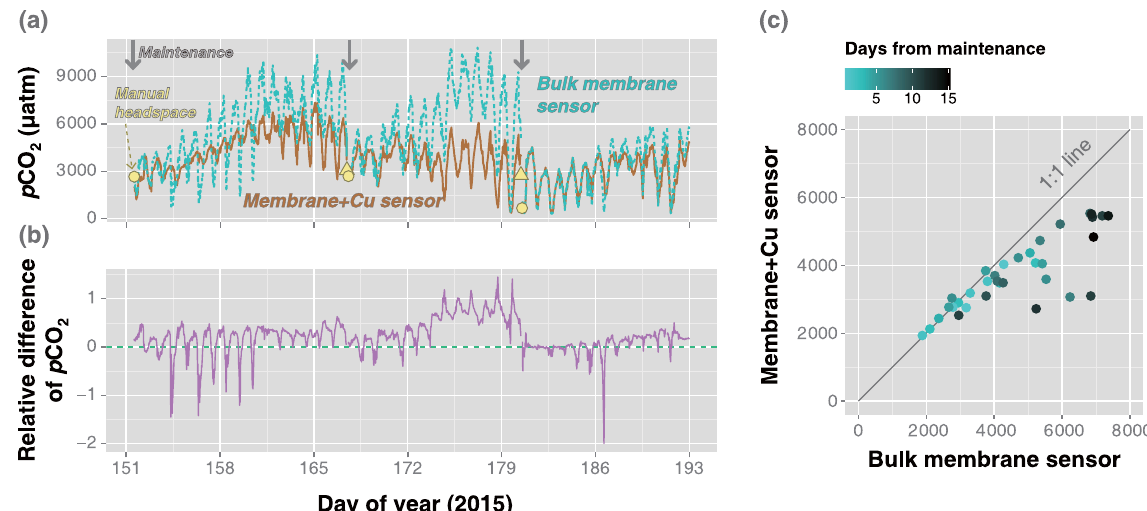
Figure 6. Continuous p CO 2 measurements at a tidal reach of the Han River using membrane-enclosed sensors without (bulk membrane sensor) and with copper mesh screen (membrane + Cu sensor), with (a) original measurements (gray arrows indicate maintenance timing), (b) relative differences between the log-transformed measurements by the two sensors, and (c) the relationship between the daily means of p CO 2 measurements by the two sensors. Yellow triangles and circles indicate p CO 2 measurements using manual headspace equilibration immediately before and after maintenance,